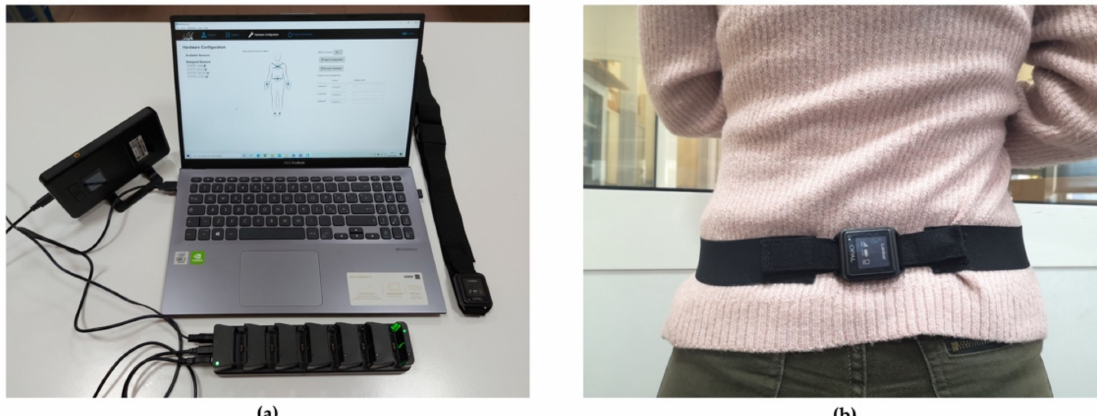
Figure 1. ( a ) Opal System: Access Point, Docking Station, Opal Sensor and Mobility Lab software. ( b ) Placement of the Opal Sensor in lumbosacral region through an elastic